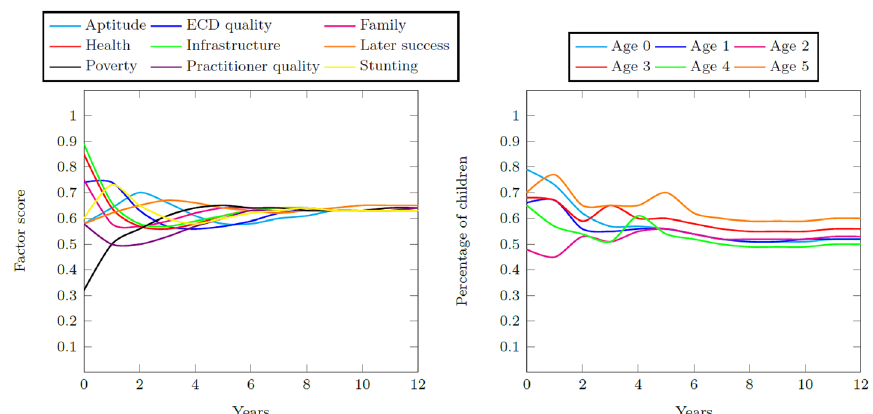
Fig. 11 Factor scores during the 12-year simulation period and the percentage of children with